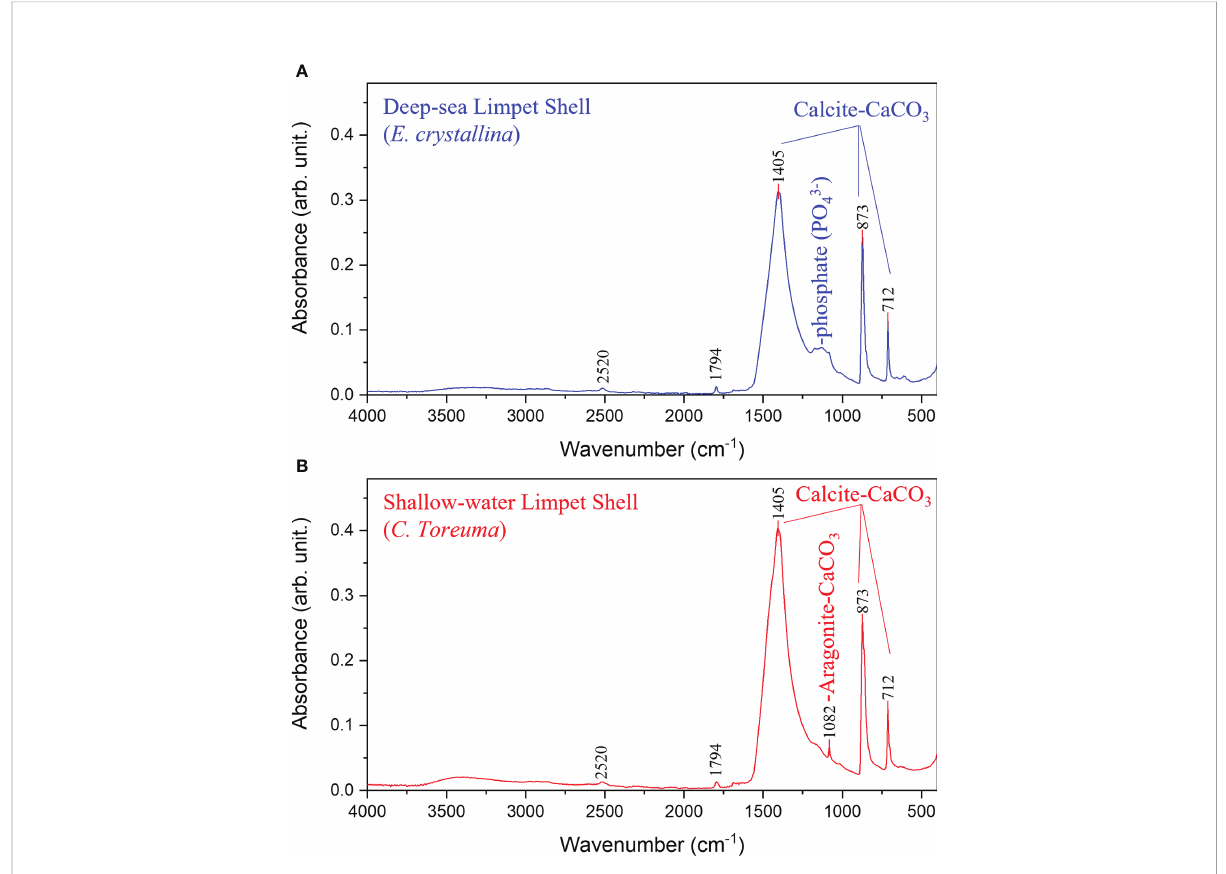
FIGURE 7 The FT-IR spectra of (A) deep-sea limpet E. crystallina shells containing calcite-CaCO 3 and unique phosphate ( PO 3 4 ) and (B) shallow-water limpet C. toreuma shells containing two CaCO 3 polymorphs, calcite-CaCO 3 and aragonite-CaCO 3